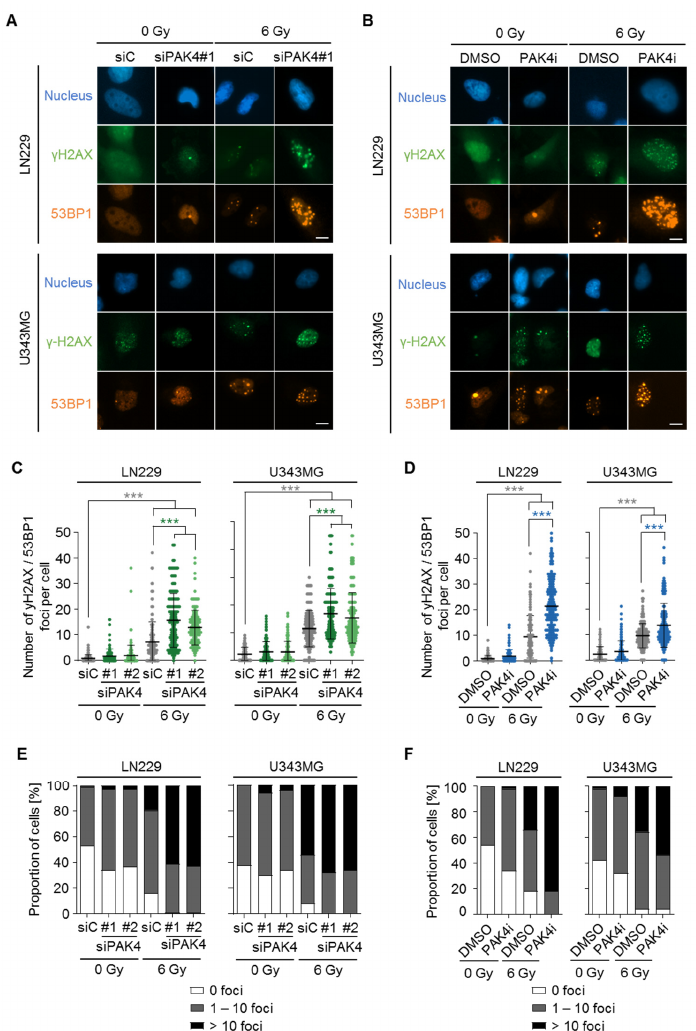
Figure 4. PAK4 depletion triggers an accumulation of DNA double-strand breaks. ( A , B ) Representative immunofluorescence images of the nucleus (DAPI), γ H2AX, and 53BP1 in LN229 and U343MG cells upon treatment with ( A ) siPAK4#1 and ( B ) PAK4i EC50 without or in combination with 6 Gy X-ray irradiation. Scale bar: 5 µm. ( C , D ) Quantification of γ H2AX/53BP1 foci in LN229 and U343MG cells upon ( C ) siRNA-mediated depletion of PAK4 and ( D ) PAK4i treatment in unirradiated and 6 Gy X-ray irradiated cells. ( E , F ) Proportion of cells with indicated numbers of γ H2AX/53BP1 foci upon ( E ) depletion of PAK4 and ( F ) PAK4i treatment before and after 6 Gy X-ray irradiation. ( C – F ) Data show means +/ − SDs (N = 3 independent experiments, ∑ n = 150 cells per treatment condition), one-way ANOVA, Bonferroni’s post-hoc test, *** p < 0.001).